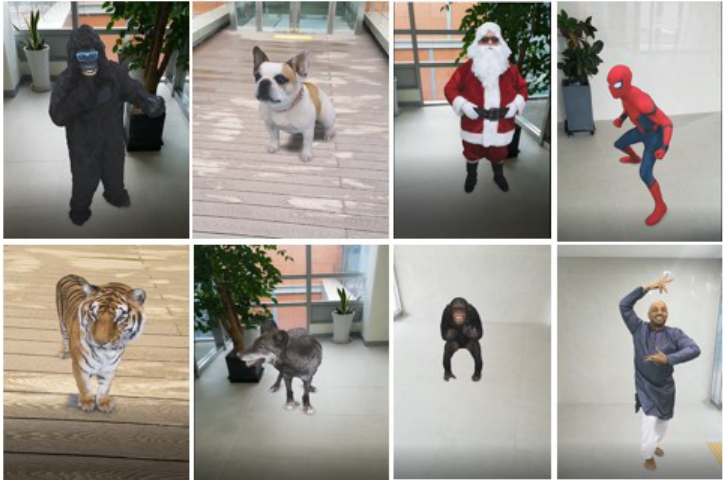
Figure 5. An example of AVD8 dataset